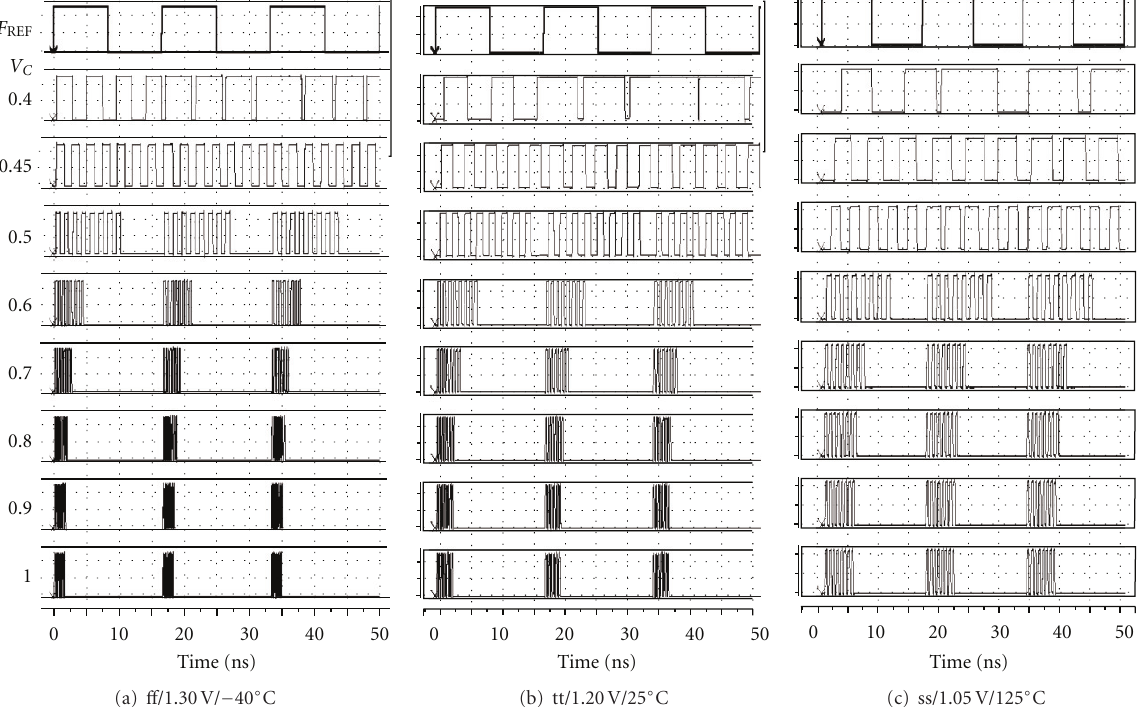
Figure 24: Postlayout simulation results from VCDL and EC applied to DLL2 for variable V C